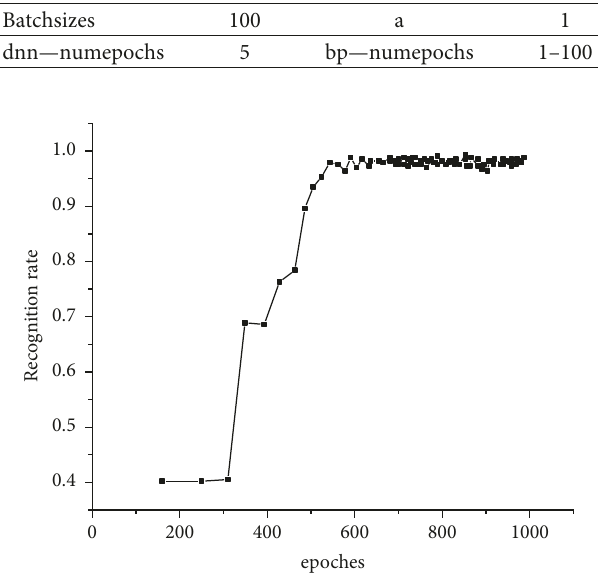
Figure 3: The rate of discriminative recognition of s/u/v by the degree neural network varies with the number of iterations. Table 3: Deep neural network parameter